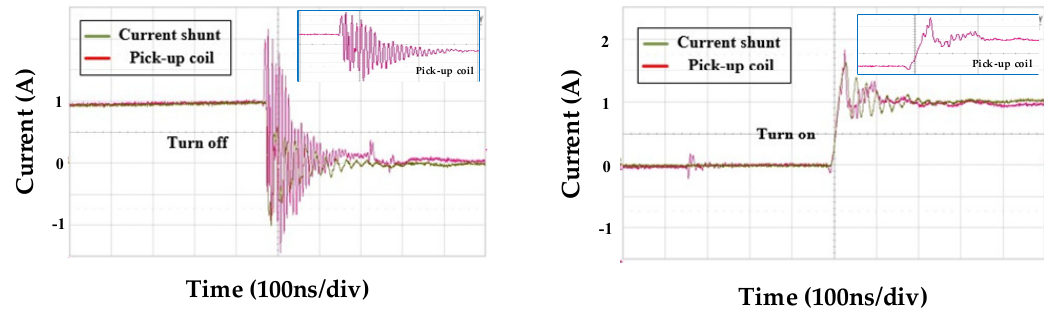
Figure 11. Comparison of the measured integrator output waveforms of the two-layer spiral coil and shunt resistor sensor at dc link voltage V dc of 250 V.